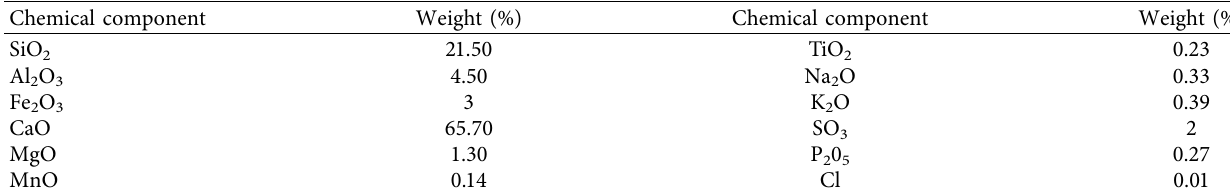
Table 2: Chemical properties of Portland cement (%).